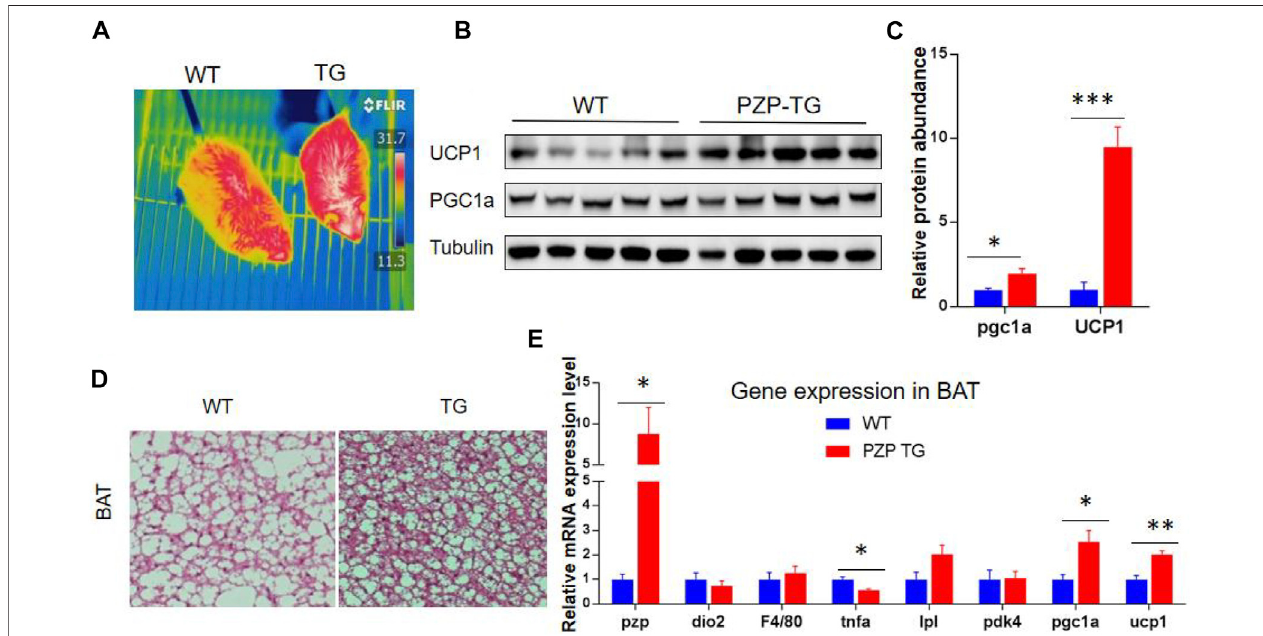
FIGURE3| BATactivitywasincreasedinPZPTGmice. (A) SurfacetemperatureofWTandPZPTGmiceafterrefeedingtimewasmeasuredbytheinfraredimager. (B,C) Immunoblots of total BAT lysates from WT and PZP TG mice showed UCP1 and PGC1a levels increased in PZP TG mice ( n = 5). (D) Representative H&E staining images of BAT from WT and PZP TG mice show that PZP TG mice under IF conditions had smaller adipocytes and less lipid accumulation in the liver (scale bar = 100 μ m). (E) Relative mRNA expression of adipogenic, thermogenic, and in fl ammatory genes in BAT from WT and PZP TG mice ( n = 7).